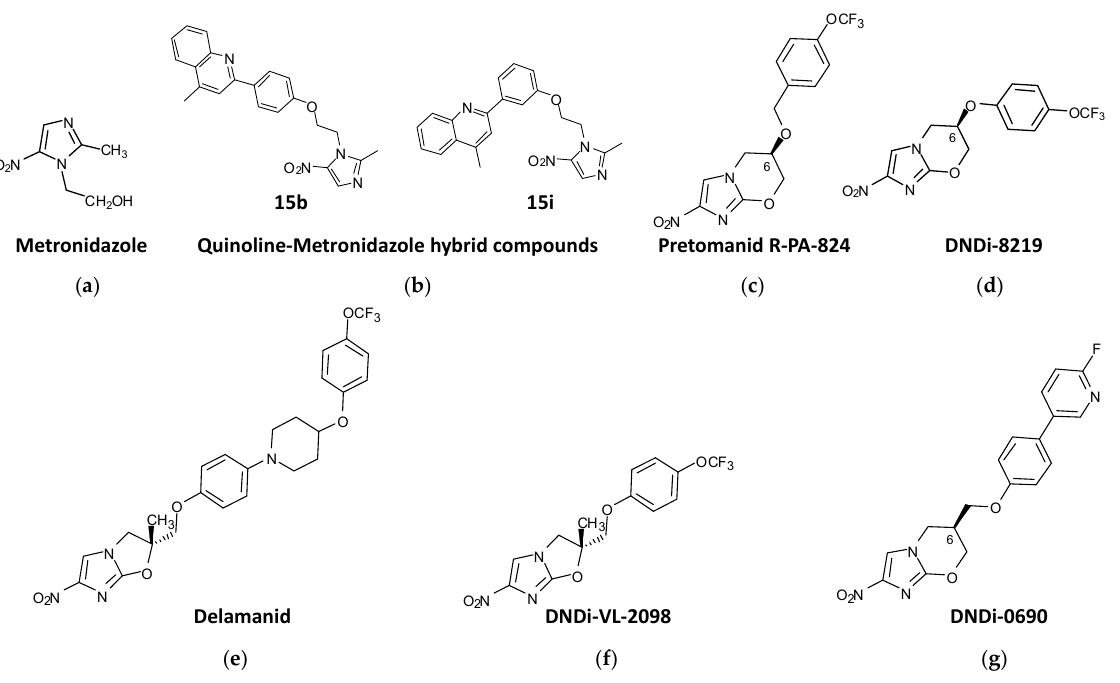
Figure 5. Nitroimidazole compounds in different stages of development against trypanosomatids. ( a ) Metronidazole. ( b ) Quinoline-Metronidazole hybrid compounds 15b and 15i. ( c ) Pretomanid R-PA-824. ( d ) DNDi-8219. ( e ) Delamanid. ( f ) DNDi-VL-2098. ( g ) DNDi-0690.